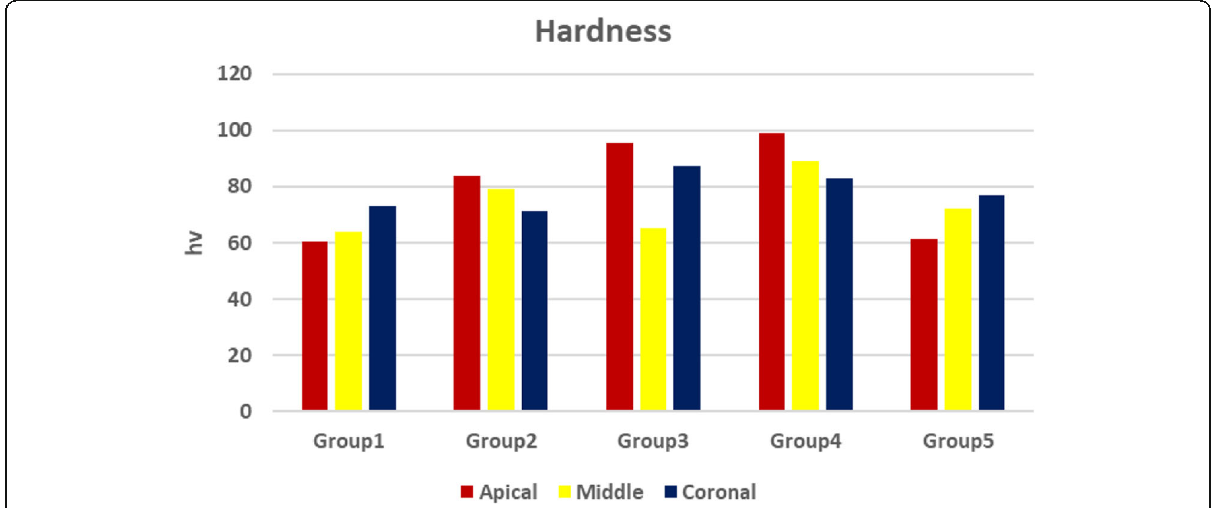
Fig. 2 Histogram showing the microhardness for each group in each